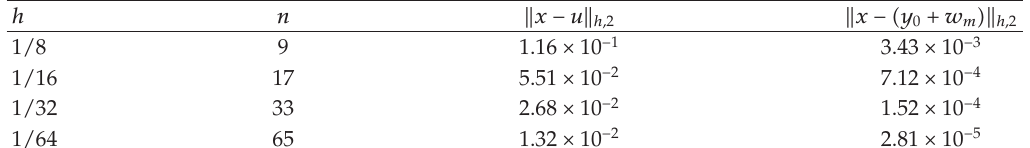
Table 2: Compared